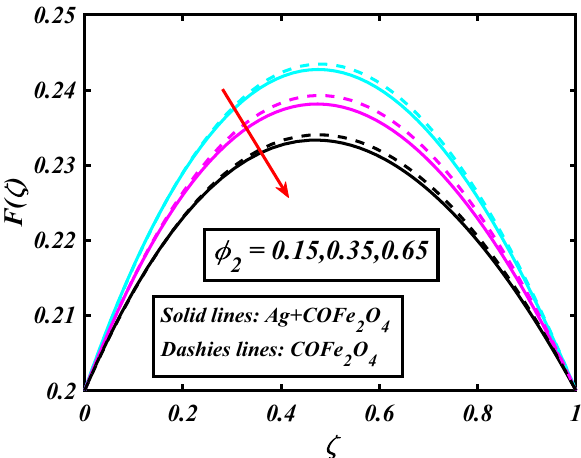
Figure 3. Demonstration of φ 2 through F (ζ) .